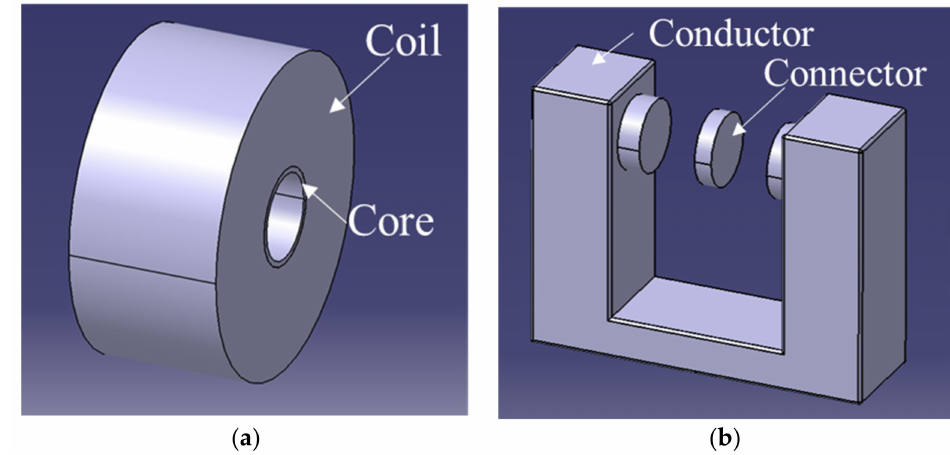
Figure 13. Components of adaptive tuned MRE vibration absorber. ( a ) coil part, ( b ) magnetic conductor and connector.